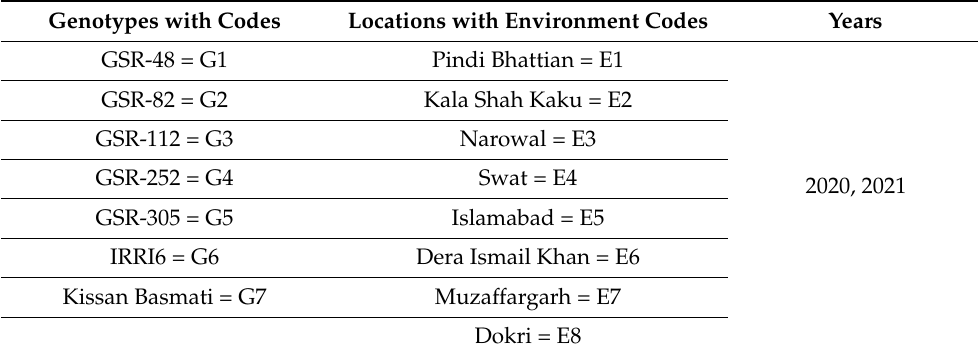
Table 1. Code for genotypes name and locations evaluated during the two